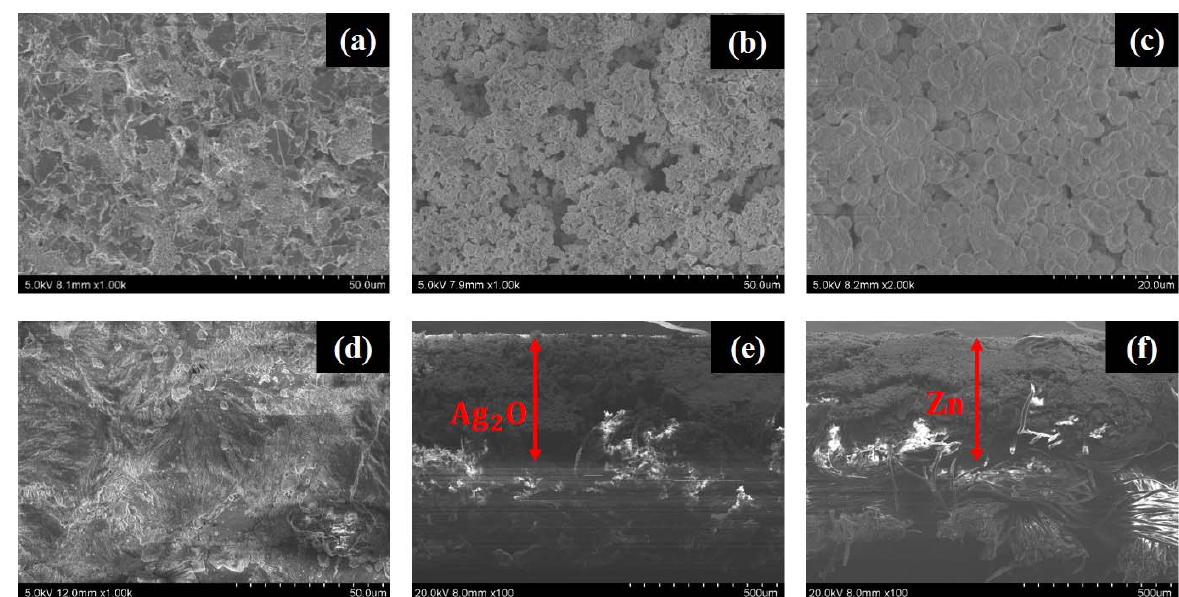
Figure 3. The HRSEM images of the printed layers. Top surface of the ( a ) carbon, ( b ) silver oxide, ( c ) zinc, and ( d ) polyethylene oxide (PEO)-based gel electrolyte layers. Cross-sectional SEM image of the ( e ) Ag 2 O and ( f ) Zn electrode.